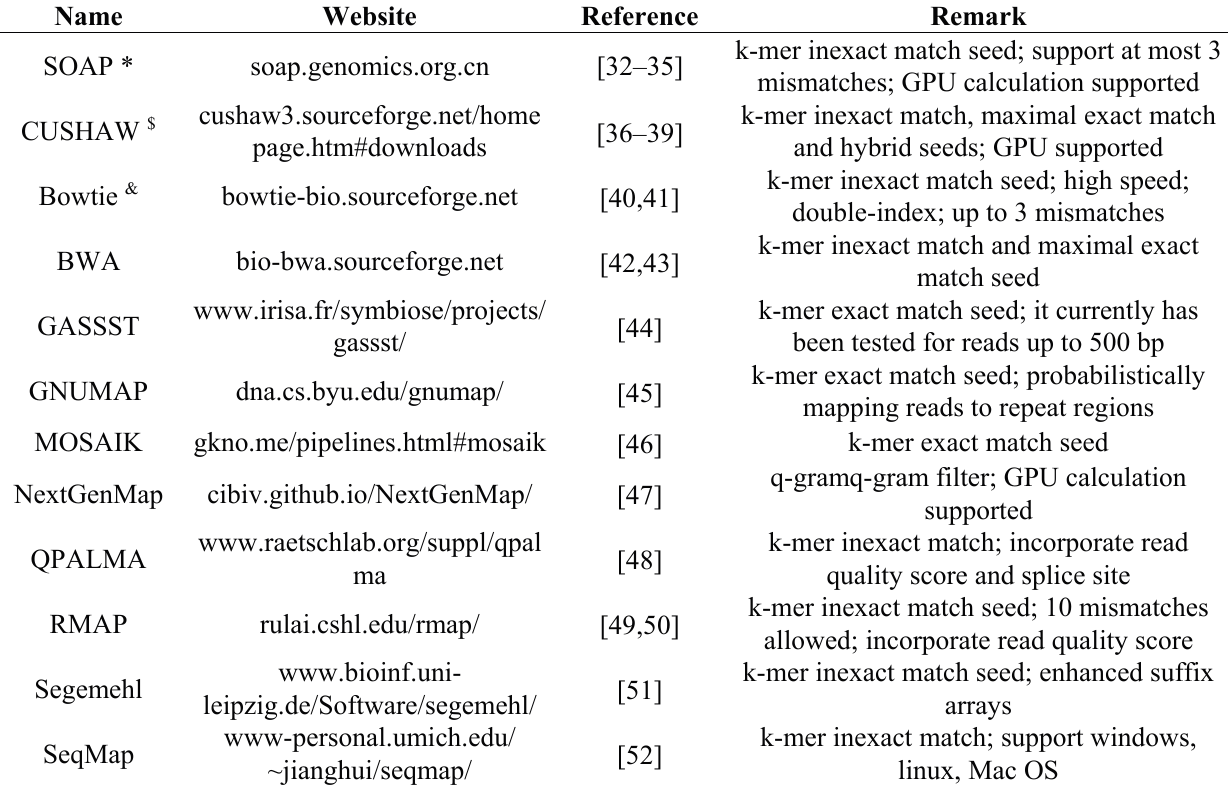
Table 2. Alignment algorithms and software